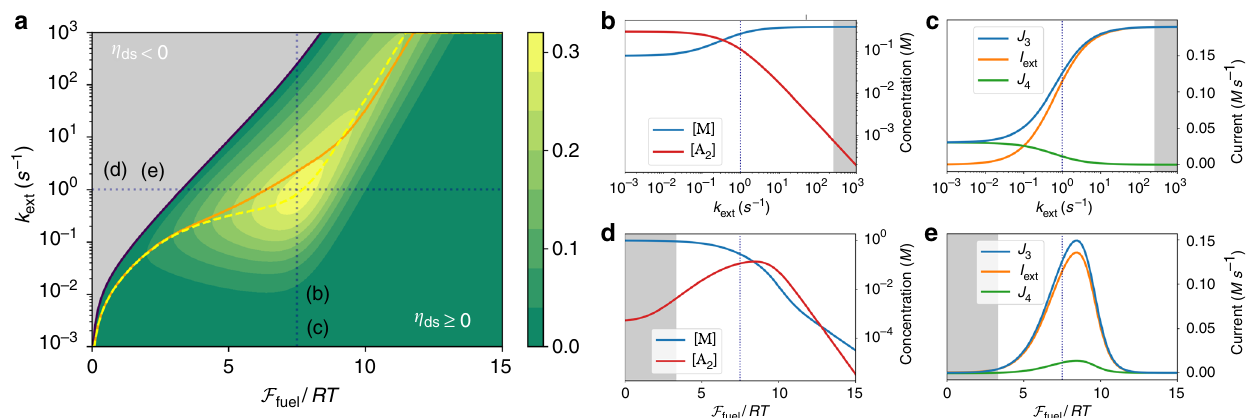
and k ext . Regions of operating regimes that do not perform fuel , see also Supplementary Fig. 2) ext ) along the line fuel